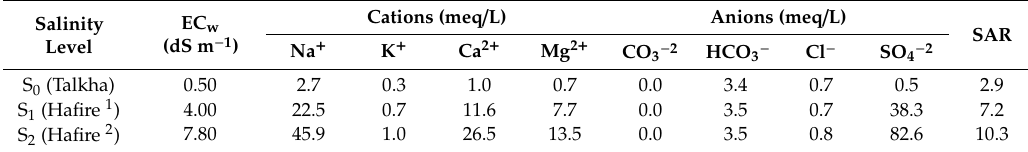
Table 3. Chemical analysis of irrigation water for the three sites.